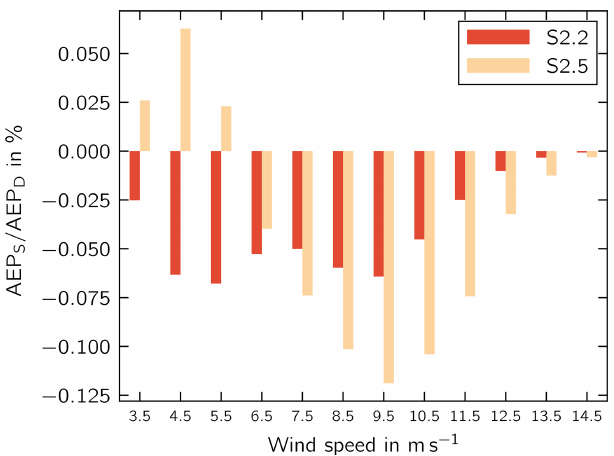
Figure 8. Annual energy production per wind speed bin in imbal- ance scenarios (AEP S ) compared to the design situation (AEP D